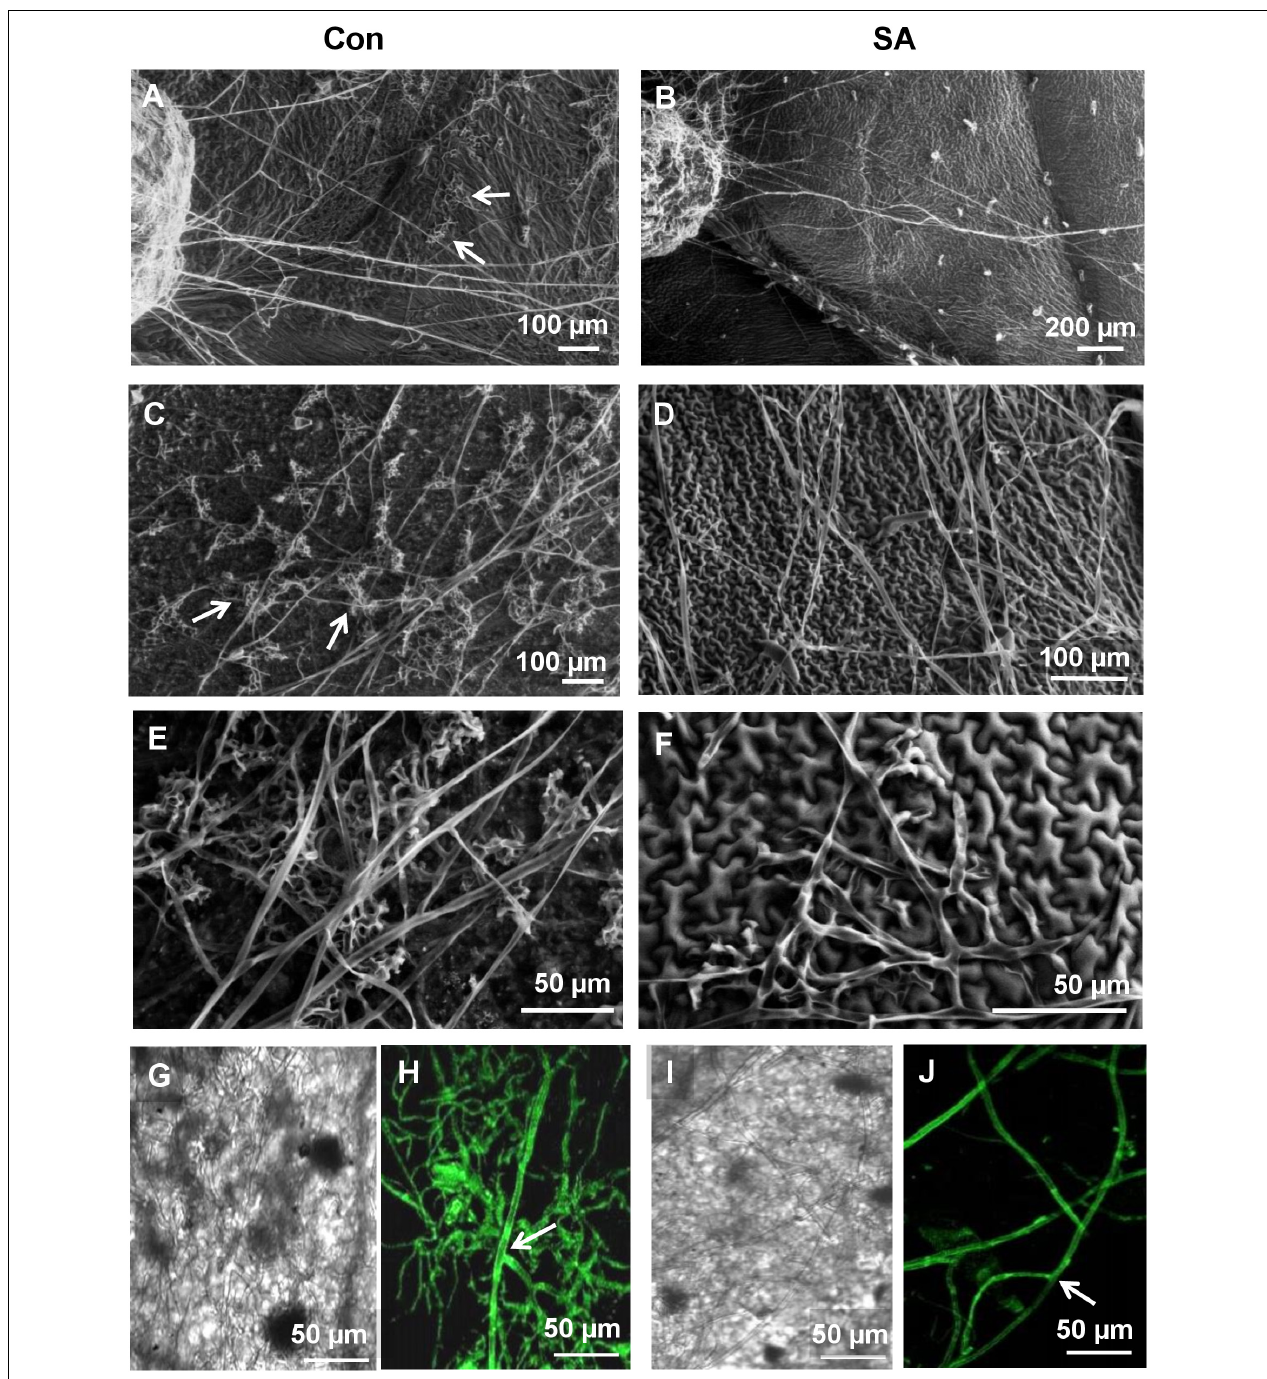
FIGURE 3 | Scanning Electron Microscopy and Confocal Laser Scanning Microscopy (CLSM) to observe differential behavior of sclerotia and the newly emerging infection hyphae of R. solani transformed with gfp gene on SA-primed and control leaves up to 48 hpi. (A) SEM of germinating sclerotia showing profuse growth on the control leaf, presence of hyphal aggregation, and initiation of infection cushions (arrows) at 24 hpi. (B) Delayed germination of sclerotia with significantly less emerging hyphae and no infection cushion on the surface of SA-primed leaf at the same point (C) Numerous infection cushions on control leaf surface at 48 hpi (D) Hyphae growing in straight lines with scant hyphal branching and light hyphal aggregation at 48 hpi on SA pre-treated leaves. (E) SEM of close-up view of advanced infection cushion on the control leaf at 48 hpi (F) A close-up view of loose hyphal aggregation on SA-primed leaf at 48 hpi. (G,H) Confocal microscopy of gfp -transformed R. solani hyphae on control leaf surface at 24 hpi showing profuse branching, arrow showing right angled branching with septa typical for R. solani . Representative fluorescence fields were chosen from at least three independent plants. (I,J) Fluorescence microscopy of inoculated SA-primed leaves showing scant hyphal growth at the same time point (arrow shows right angle branching with septa typical for R. solani ).